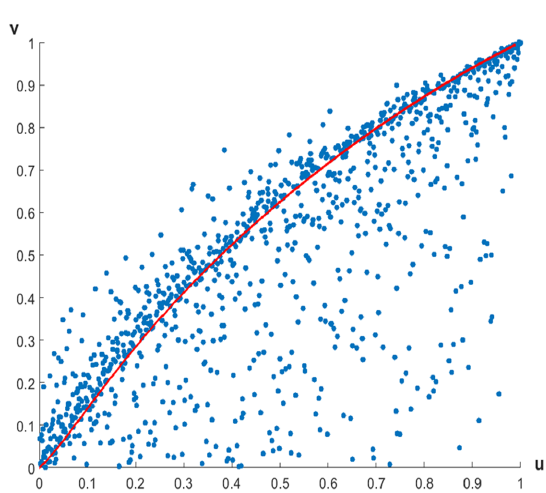
Figure 4: Scatter plot of the copula of ( X 1 , X 2 ) with the limiting curve v ( u ) = G ( F −1 ( u )) of the "line mass". This curve corresponds to the parameter setting λ 1 = λ 2 = 1 , a 1 = 2 , a 2 = ∞ ; The scatter plot shows the empirical copula of a sample of size 1000 from the model λ 1 = λ 2 = 1 , a 1 = 2 , a 2 = 20